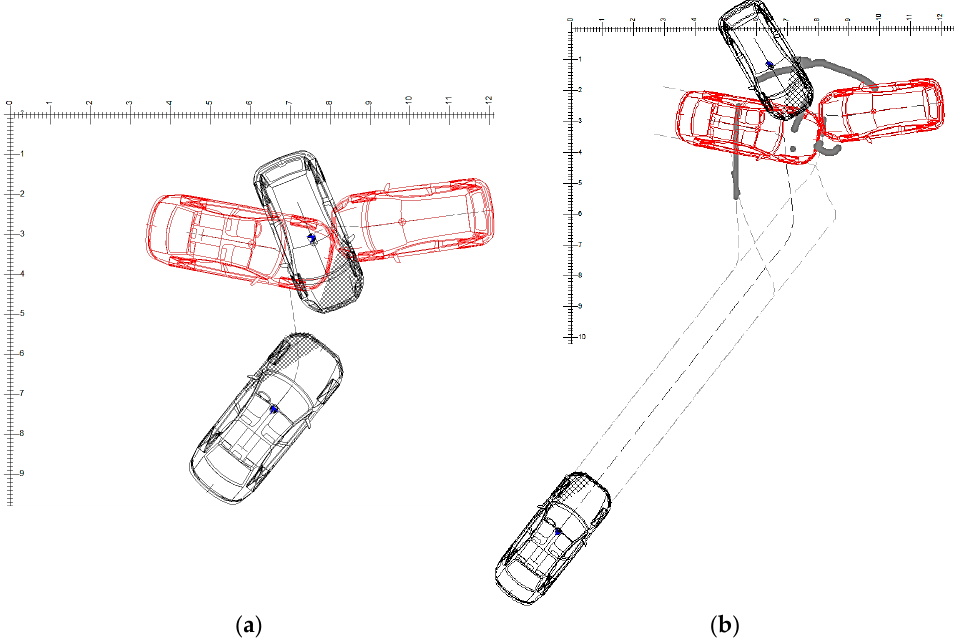
Figure 3. Post–collision locations of both passenger vehicles with ( a ) and without ( b ) the front wheels